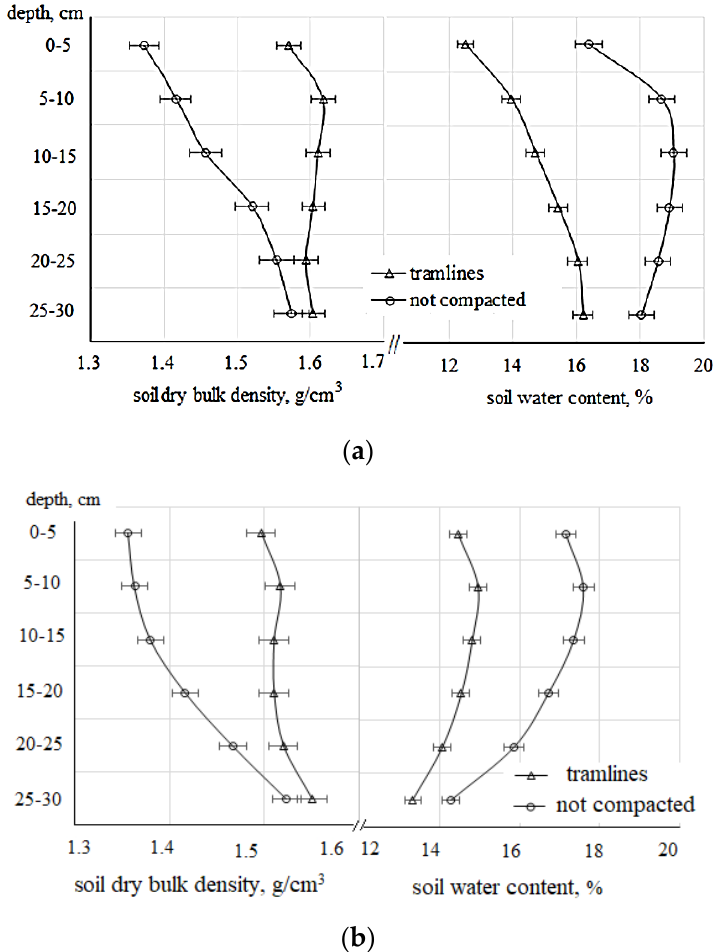
Figure 4. Soil dry bulk density and water content on clay loam ( a ) and loam soil ( b ).